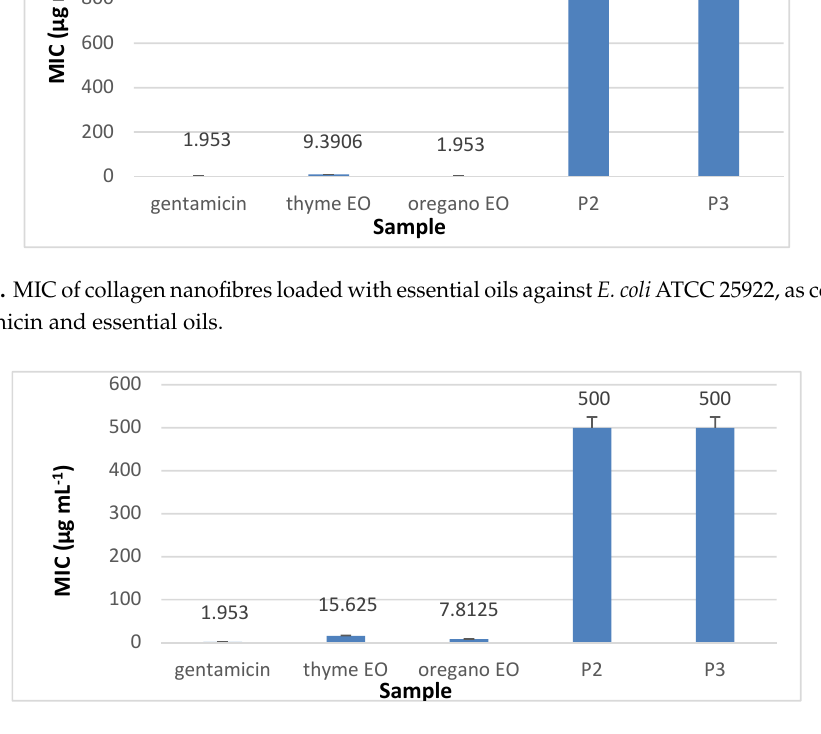
Figure 12. MIC of collagen nanofibres loaded with essential oils against P. aeruginosa ATCC 27853, as compared to gentamicin and essential oils.